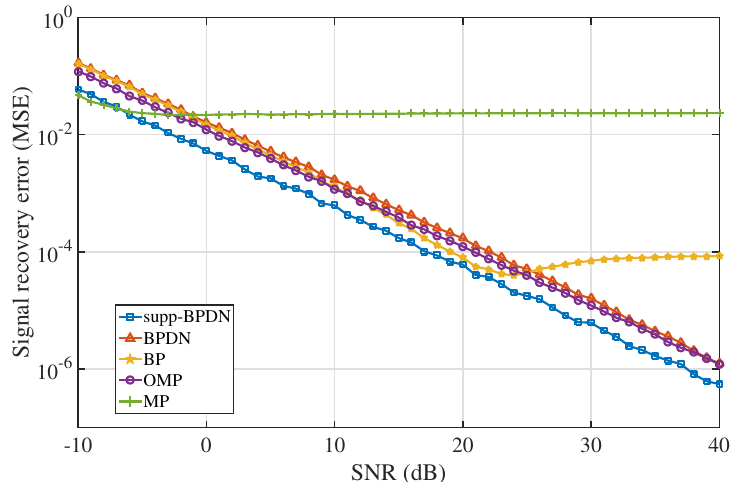
Figure 2. Signal reconstruction errors with respect to SNR among supp-BPDN, BPDN, BP, OMP, and MP algorithms using the logarithmic (base 10) scale for the y -axis.